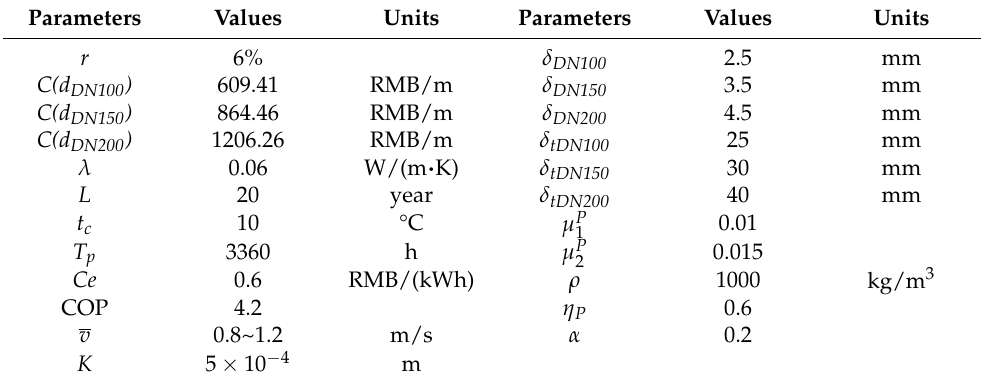
Table 2. Table of simulation references.